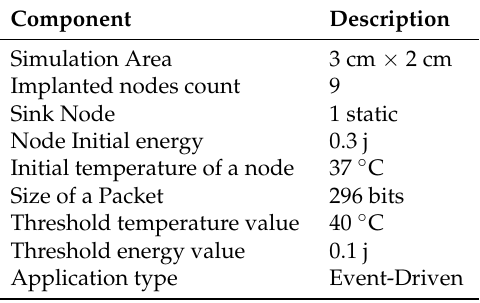
Table 4. Simulation